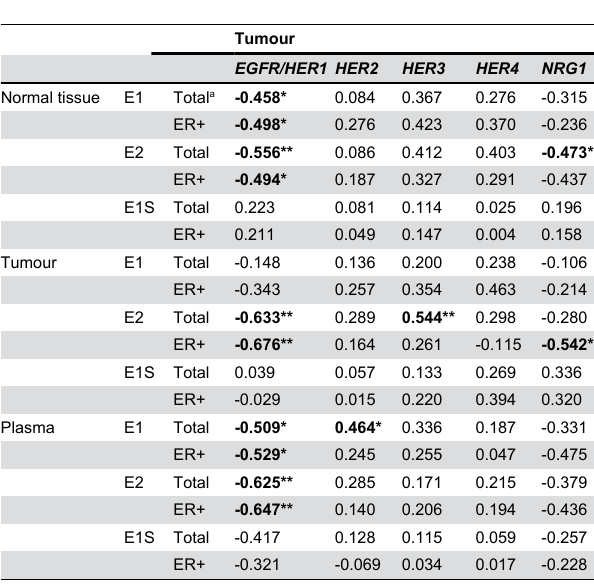
Table 5. Correlations of HER -receptors and NRG1 with estrogen levels in normal tissue, tumour tissue and plasma.